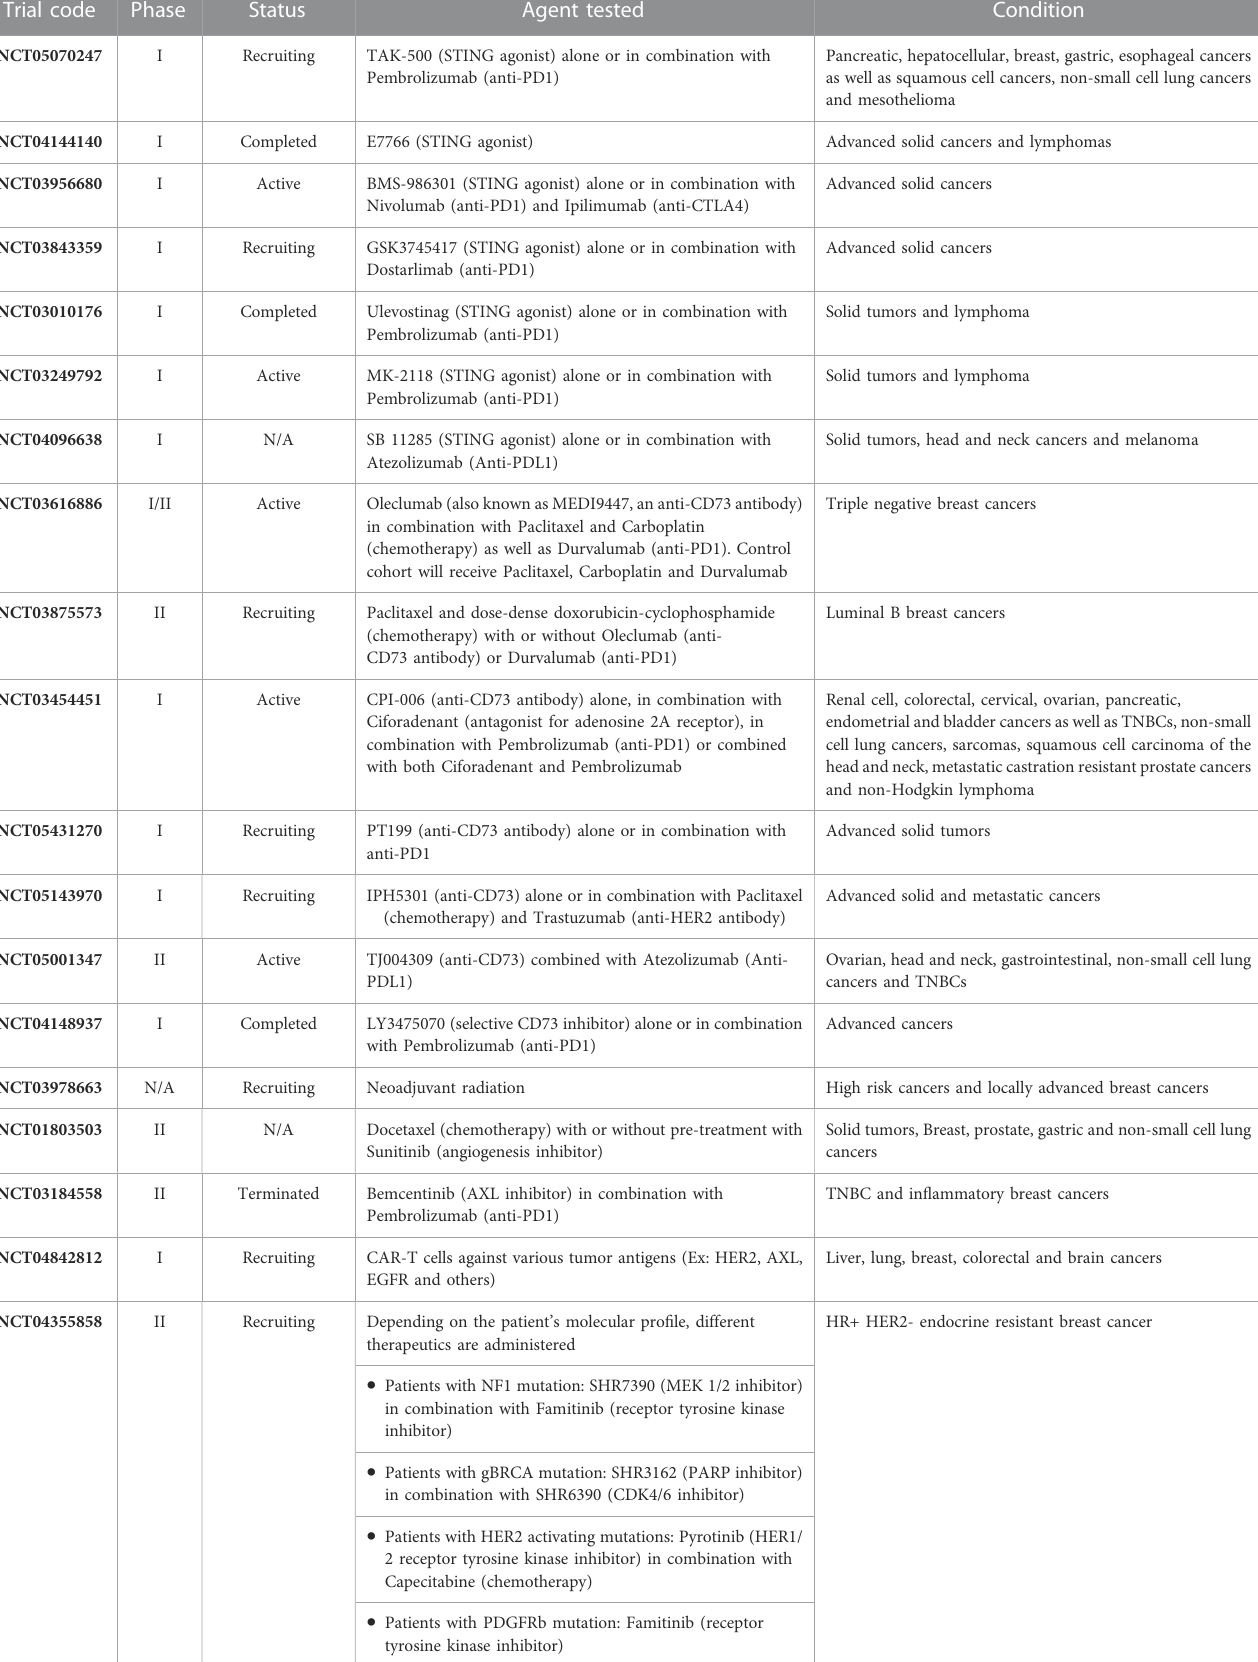
TABLE 1 Summary of the clinical trials mentioned in this paper. Ordered based on appearance in the